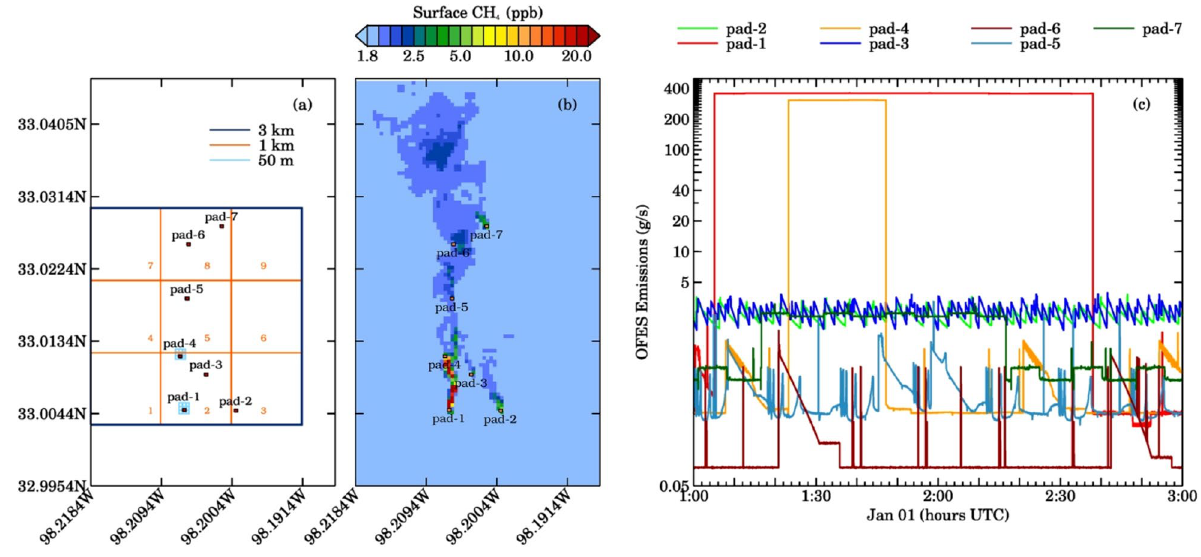
Figure 1. ( a ) High-resolution (10 m) domain of WRF-LES setup over the Barnett Shale in Texas. Three boxes represent pseudo satellite footprints at 3 km (blue), 1 km (orange) and 50 m (light blue around pads 1 and 4) spatial resolution. The location of seven oil pads is also indicated in the domain with each having multiple sources. ( b ) Spatial distribution of surface methane mixing ratio at 1:20:00 h UTC. ( c ) Input OFES emissions from seven well pads during the two-hour simulation